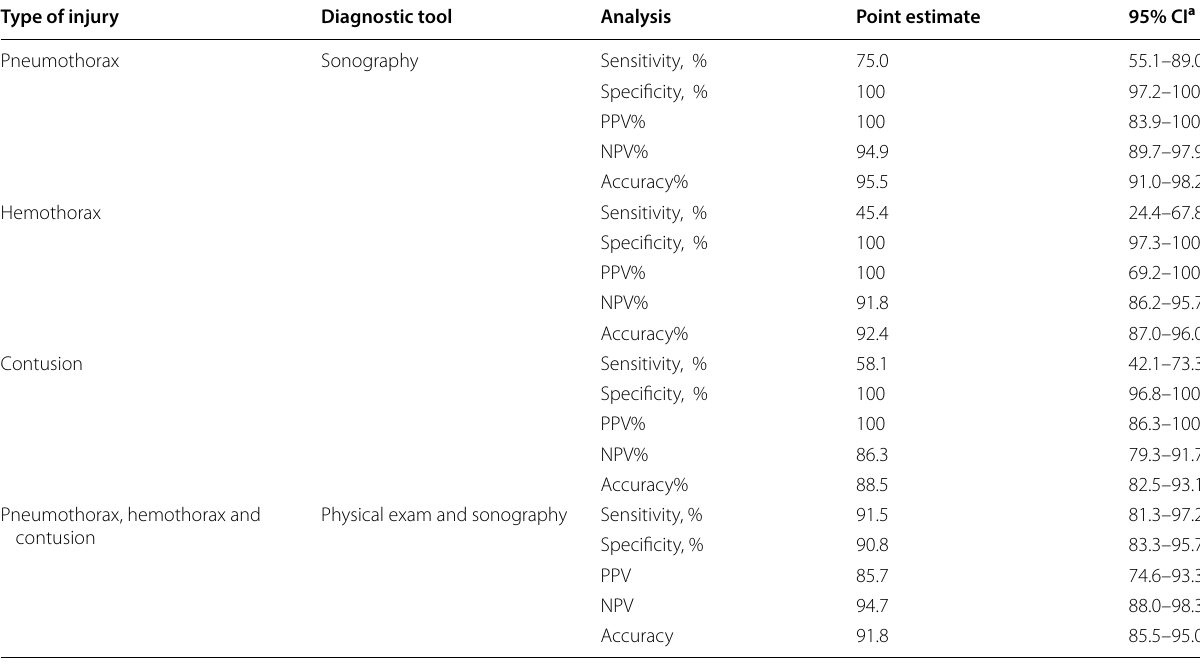
Table 3 Sensitivity, specificity, PPV, NPV and the accuracy and point-of-care ultrasound in the diagnosis of blunt chest